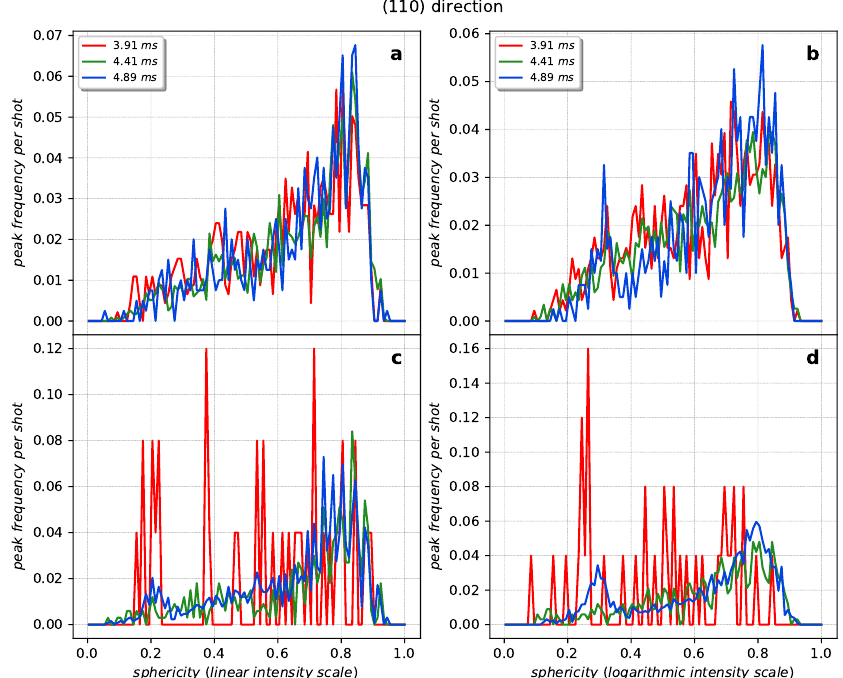
Figure A7. Frequency of a peak appearing with a certain sphericity for the (110) direction for the hits above 50 ADU/pixel ( a ) in linear and ( b ) in logarithmic intensity scales as well as the hits below 50 ADU/pixel ( c ) in linear and ( d ) in logarithmic intensity scales.